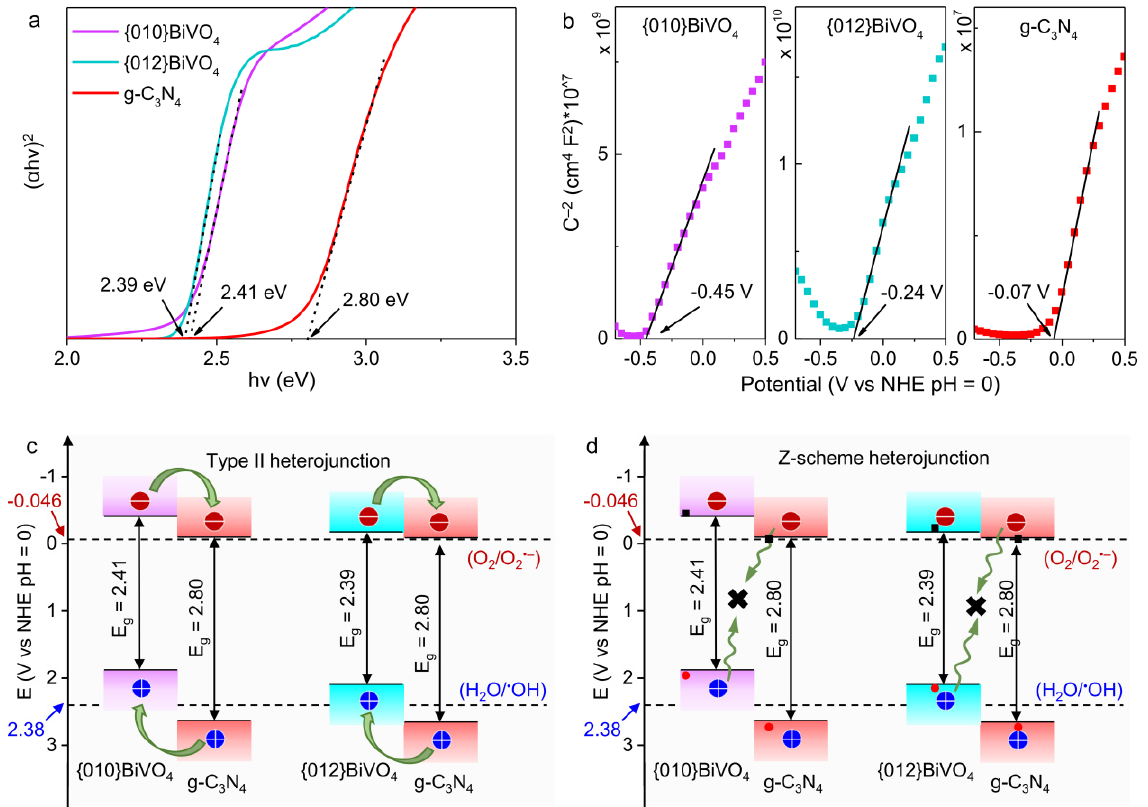
Figure 4. ( a ) Tauc curves of {010}BiVO 4 , {012}BiVO 4 , and g-C 3 N 4 for bandgap tests. ( b ) Mott–Schottky plots of {010}BiVO 4 , {012}BiVO 4 , and g-C 3 N 4 for conduction band energy tests. ( c ) The band structures of {010}BiVO 4 /g-C 3 N 4 and {012}BiVO 4 /g-C 3 N 4 with type II heterojunction. ( d ) The band structures of {010}BiVO 4 /g-C 3 N 4 and {012}BiVO 4 /g-C 3 N 4 with Z-scheme heterojunction.